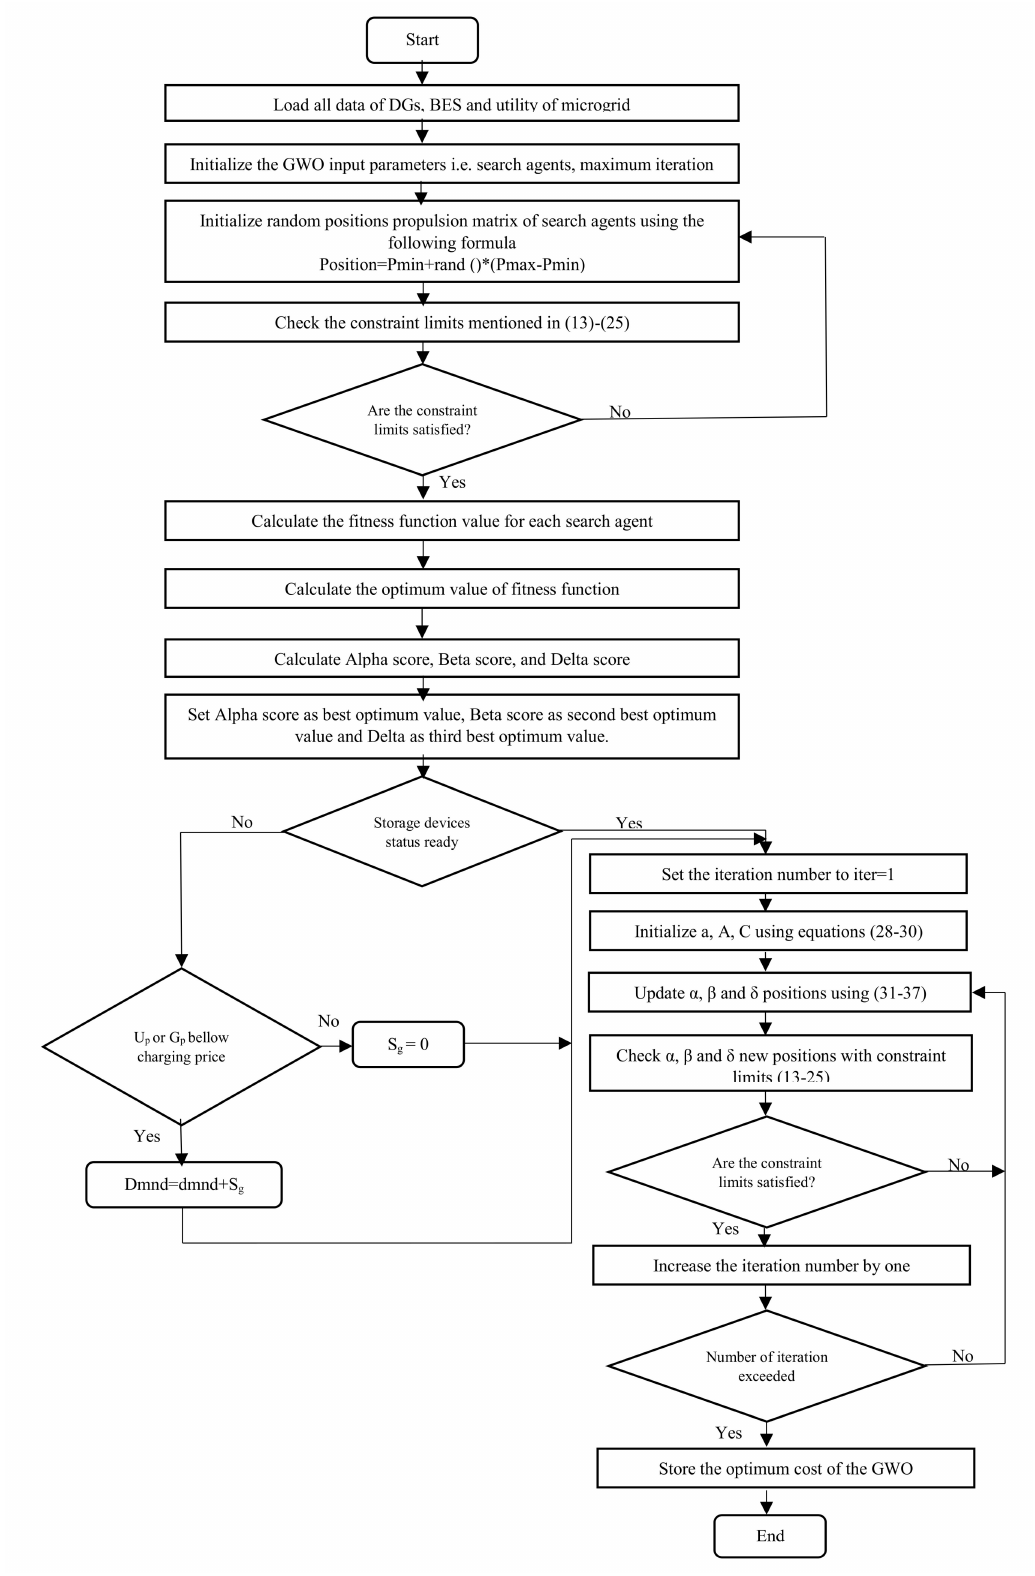
Figure 2. Flowchart of the grey wolf optimization algorithm used in the